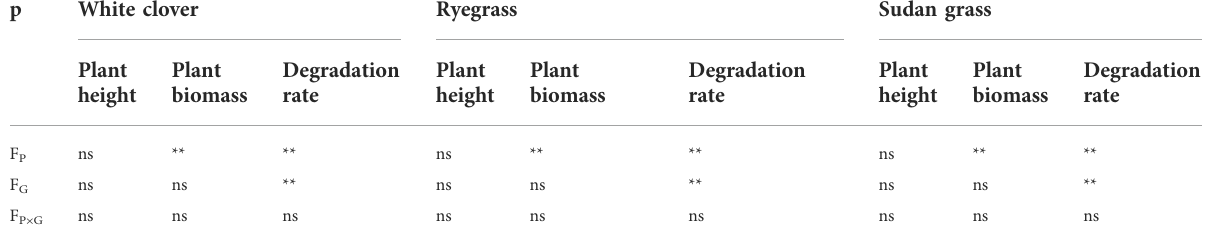
TABLE 6 Analysis of petroleum hydrocarbons concentrations, glycine addition and their interaction.